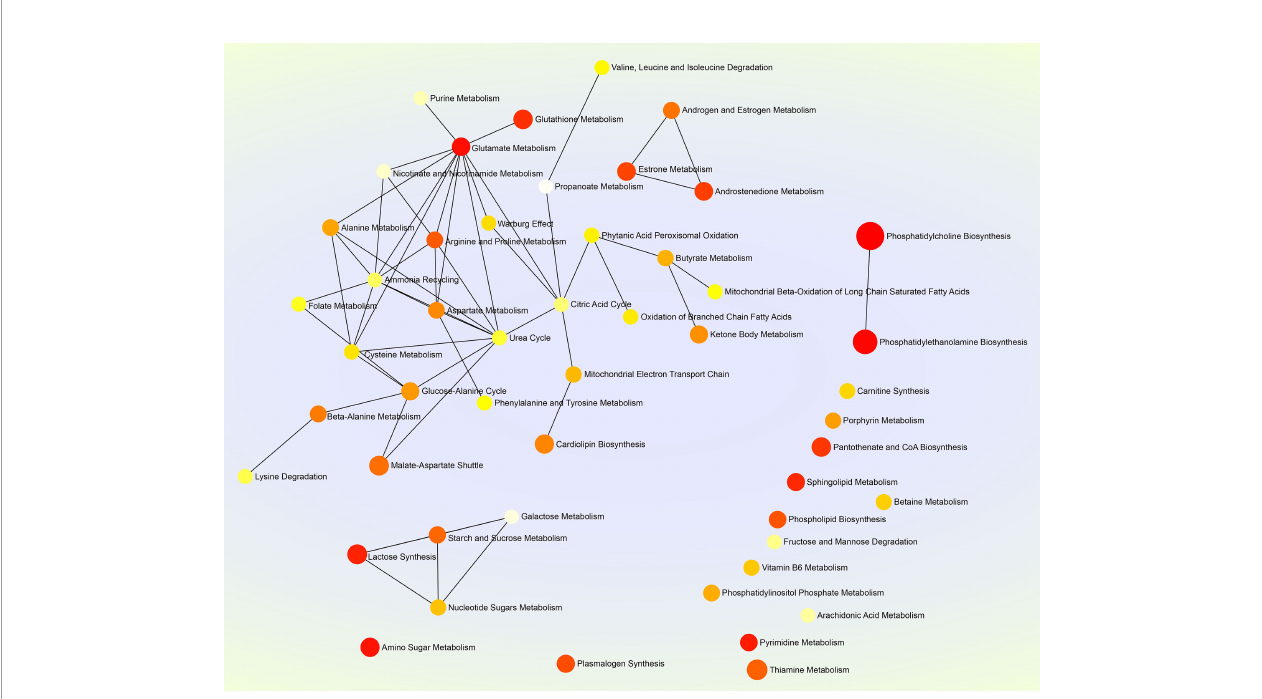
FIGURE 5 | Net map of multiple metabolic pathways. The SMPDB (https://smpdb.ca/) is used for elucidating metabolic pathways by the metabolite set enrichment analysis (MSEA) based on over representation analysis (ORA). Darker and larger nodes represent enriched pathways with lower raw p values and with higher enrichment ratios, respectively. Edges represent correlations between metabolic